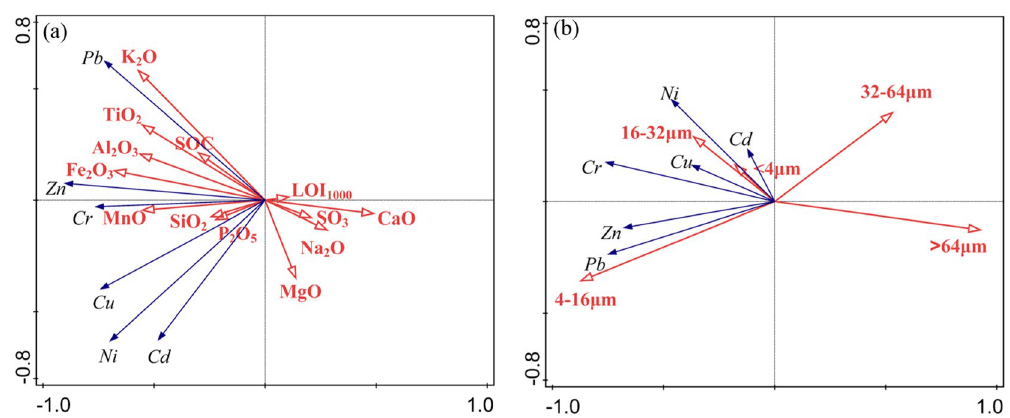
Figure 8. Redundancy analysis of HMs and whole-rock composition, soil organic carbon, and soil grain-size